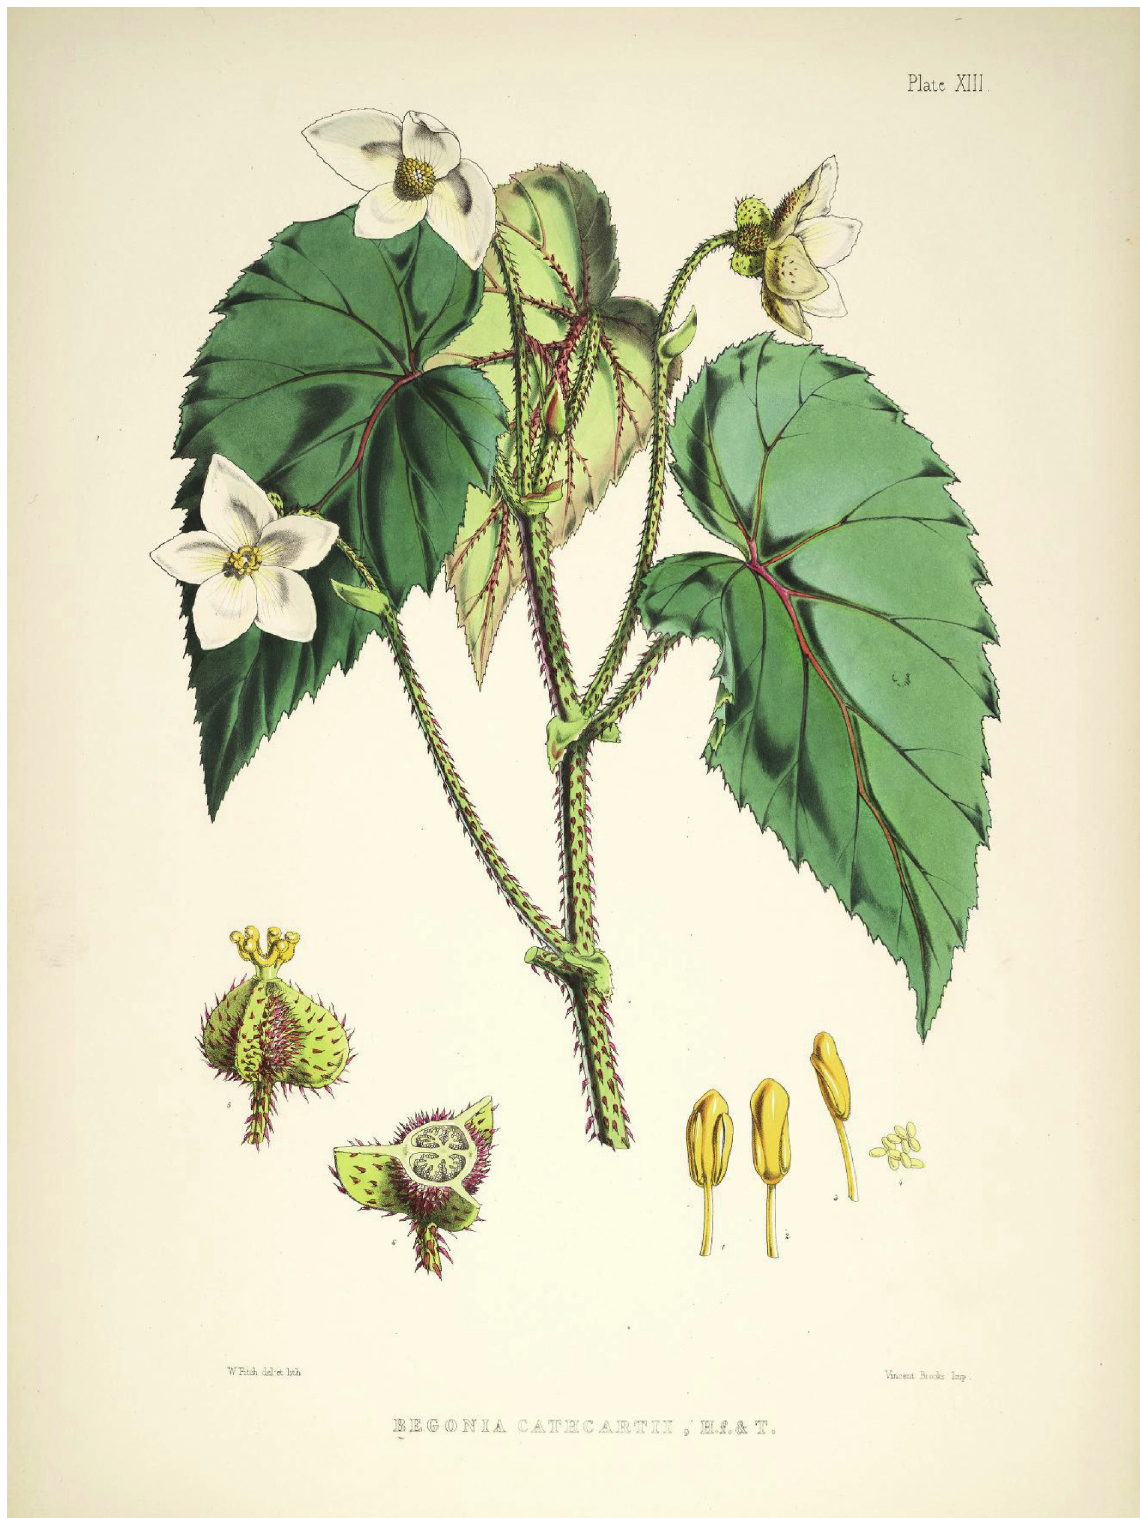
Fig. 20. Illustration of B. cathcartii Hook.f. by W.H. Fitch (Hooker 1855). 1–3. Stamen, front, back and side view. 4. Pollen. 5. Immature fruit. 6. Cross-section of fruit showing ovary placentation. Image from the Biodiversity Heritage Library, digitized by the Peter H. Raven